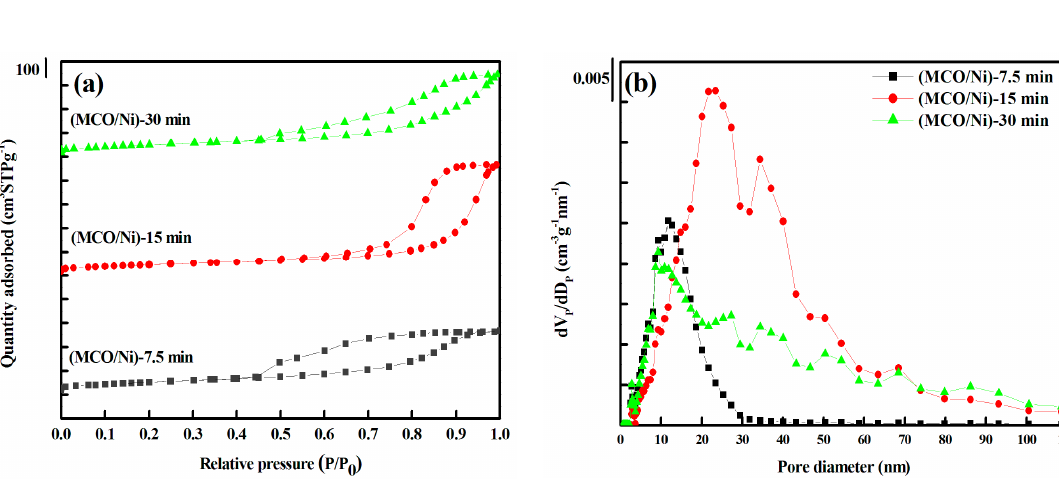
Figure 3. ( a ) N 2 adsorption/desorption isotherms and ( b ) corresponding pore size distributions of (MCO/Ni)-7.5 min, (MCO/Ni)-15 min, and (MCO/Ni)-30 min.